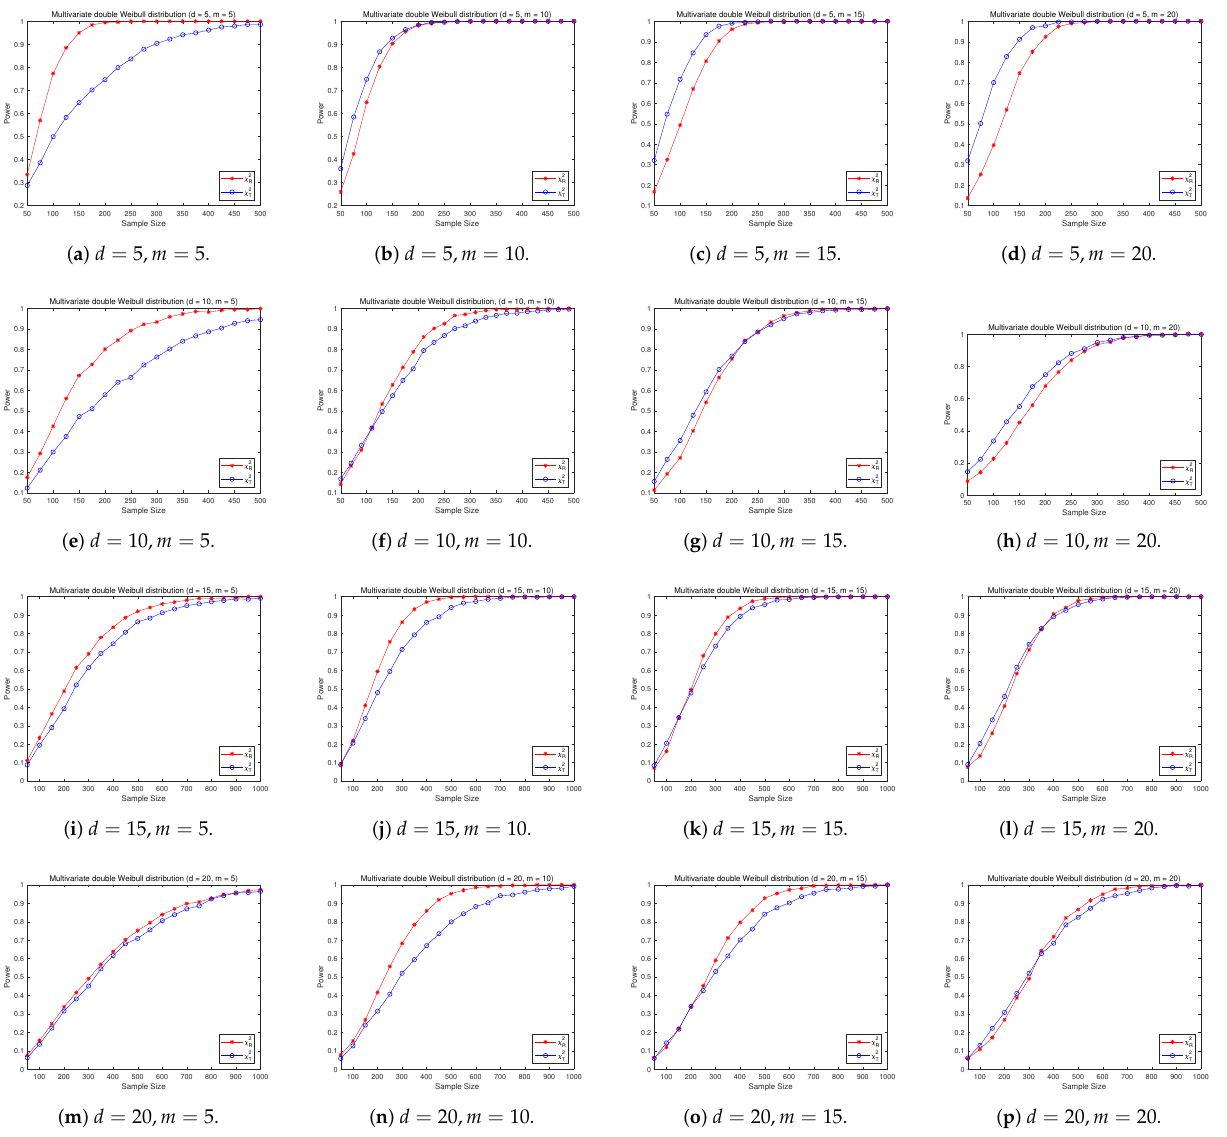
Figure 3. The double Weibulll distribution. Red line for RP-chi-square, blue line for traditional chi-square.